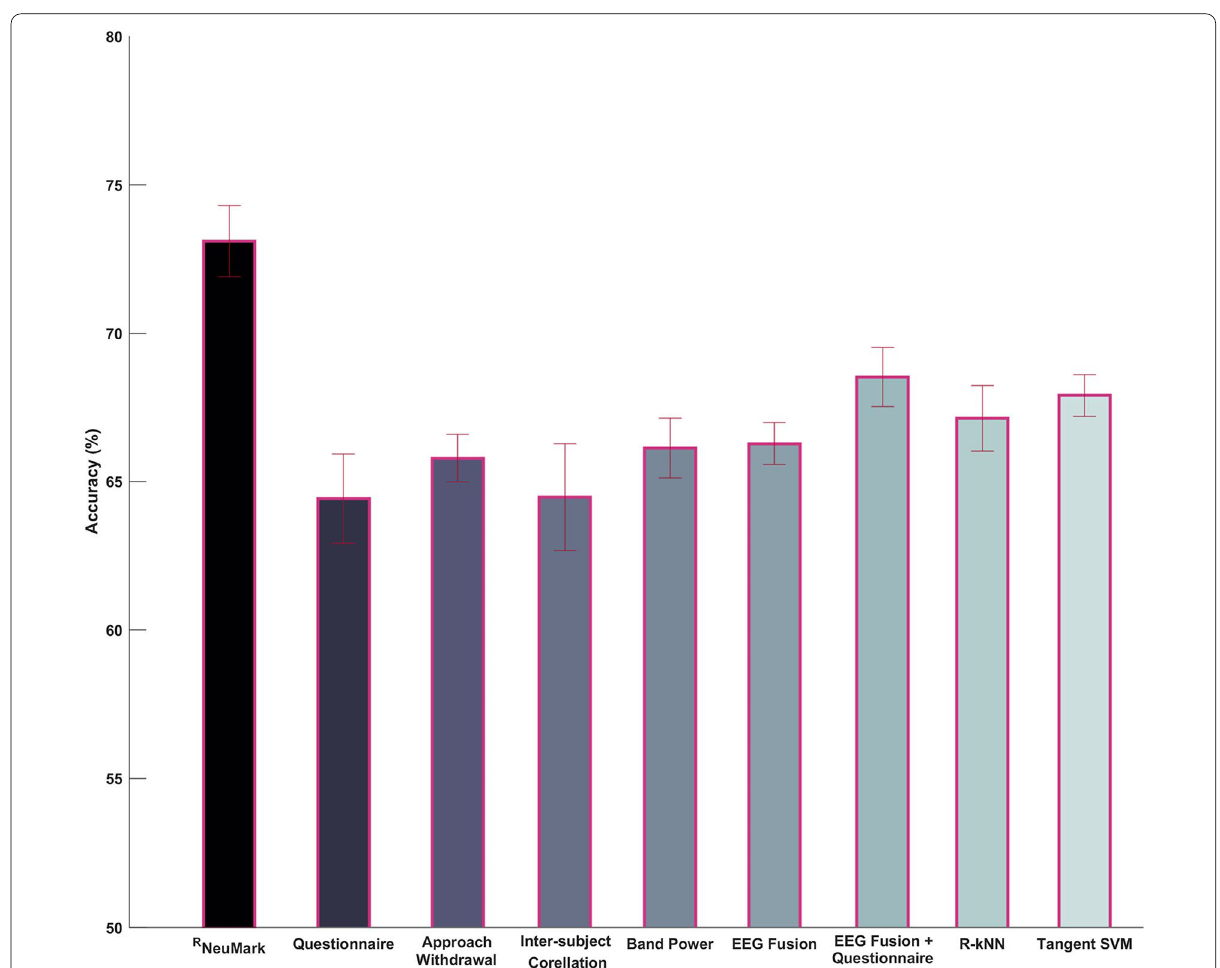
Fig. 5 Classification performance for the decoders of users’ preference in the case of dynamic